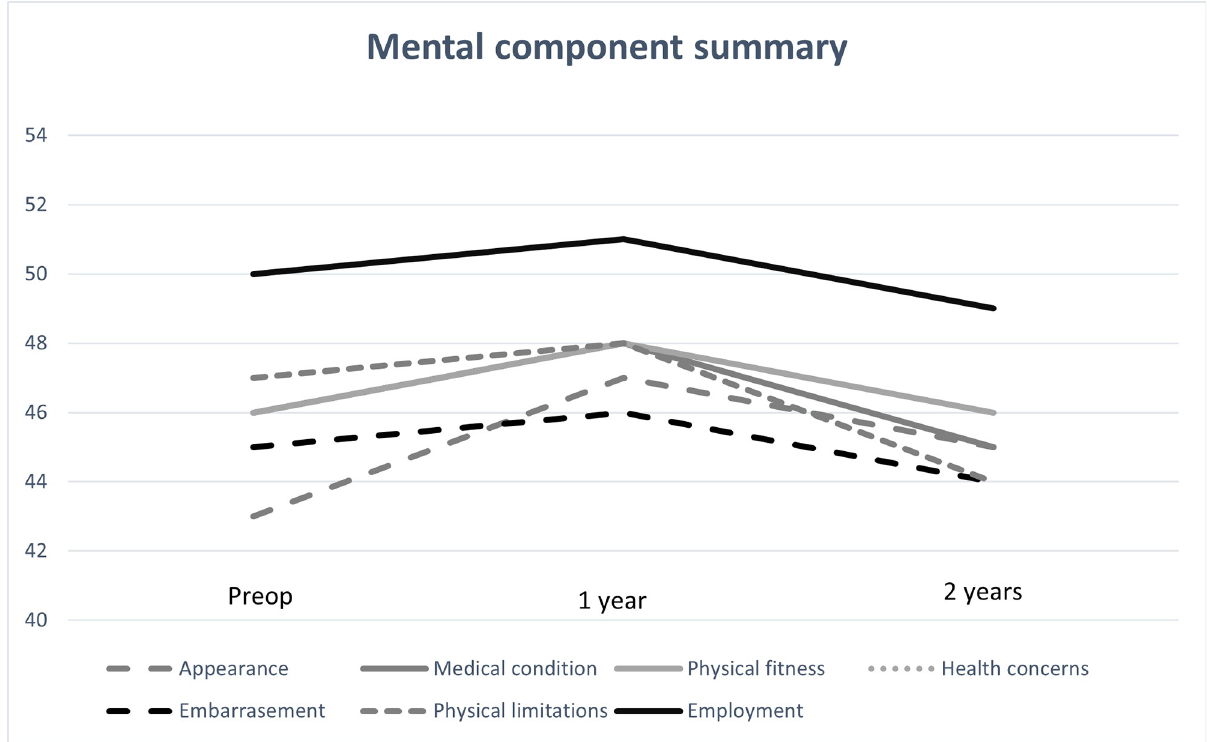
Fig 2. Mental component summary (MCS) scores and reasons for undergoing surgery, analyzed using dependent t- test. Significantly increased values 1-year after surgery in categories appearance (p = 0.026) and health concerns (p = 0.01). Missing: preoperatively n = 112, 1-year n = 179, 2-year n =